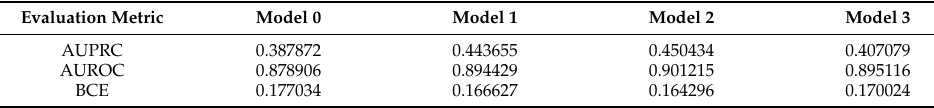
Table 4. Gross AUPRC, gross AUROC, and BCE for the test